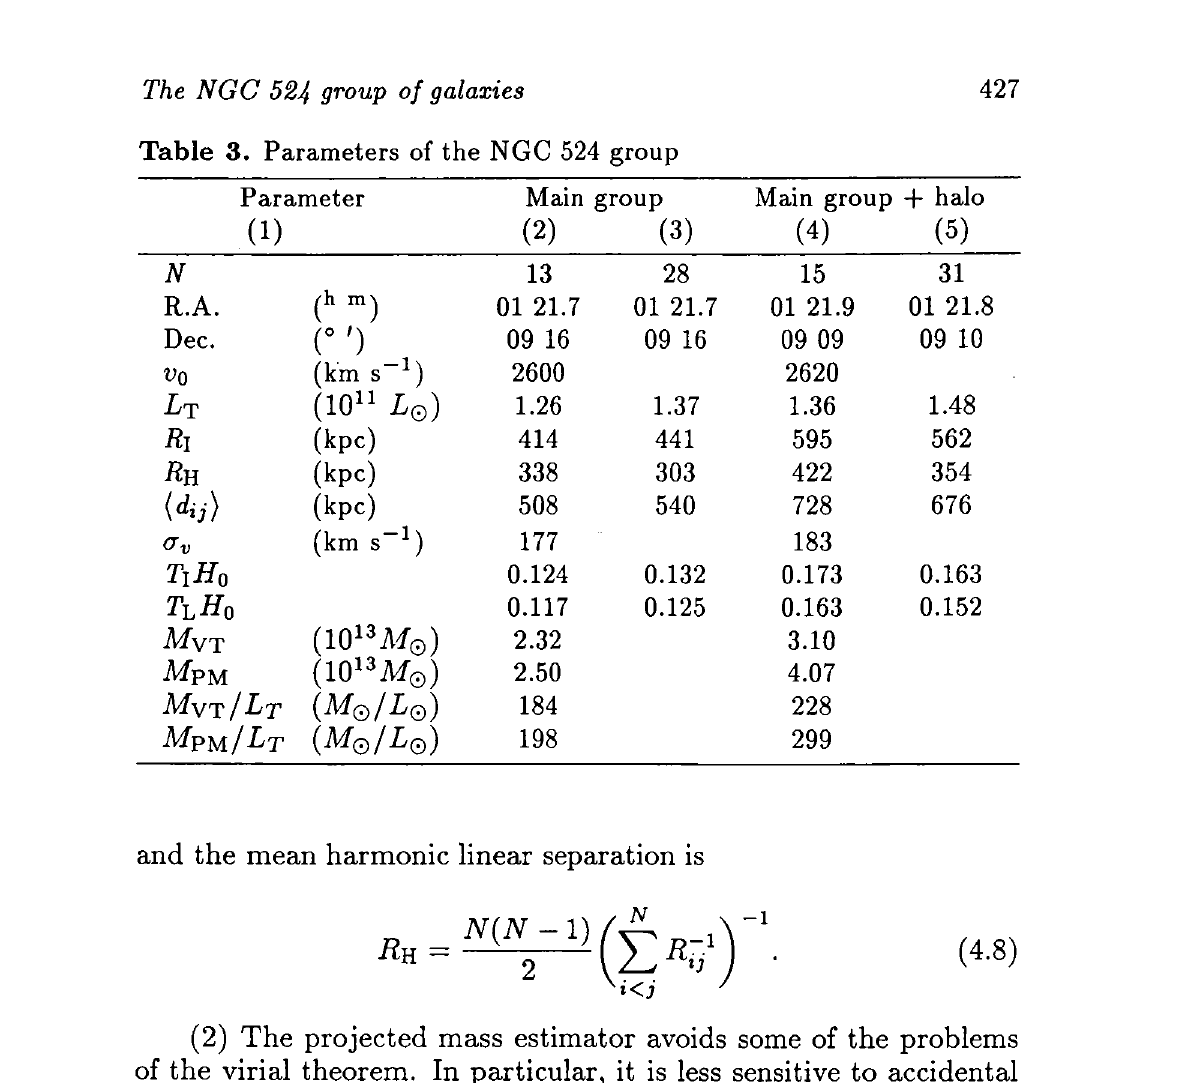
Table 3. Parameters of the NGC 524 group Parameter Main group Main group +